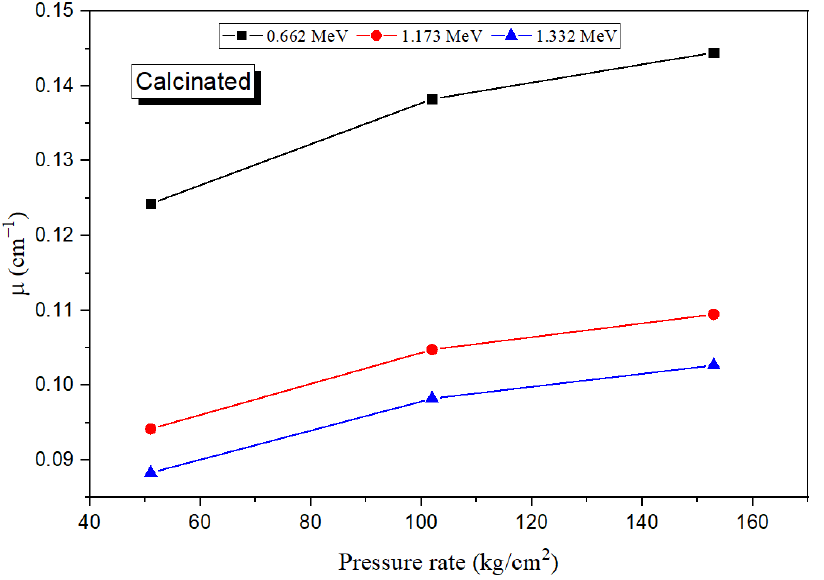
Figure 8. Variation in the linear attenuation coefficient of the calcinated bentonite as a function of the pressure rate (kg/cm 2 ).